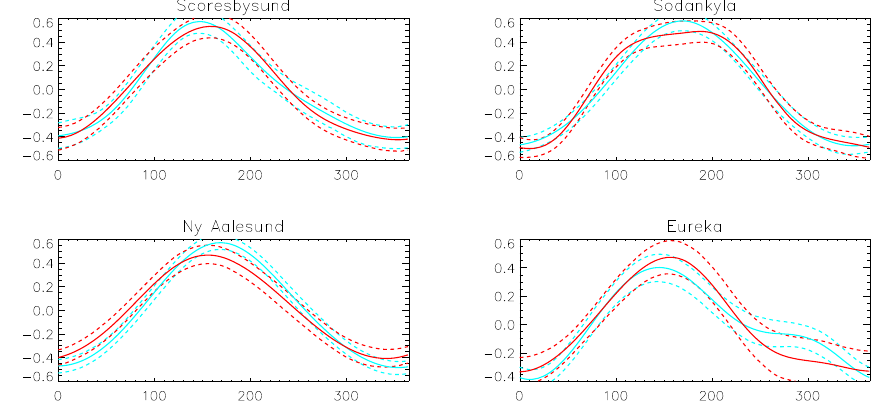
Figure 10. Average annual cycles over 1995–2000 (cyan) and 2007–2012 (red) at 500hPa. Full curve is the posterior mean, dashed curves indicate the 95% confidence intervals. Model settings: n pol = 4, n cyc = 3, n a tr = n θ tr = 2, and white noise.